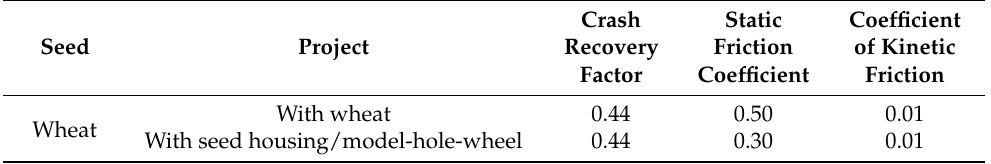
Table 3. Collision coefficients between wheat and seeding shells.